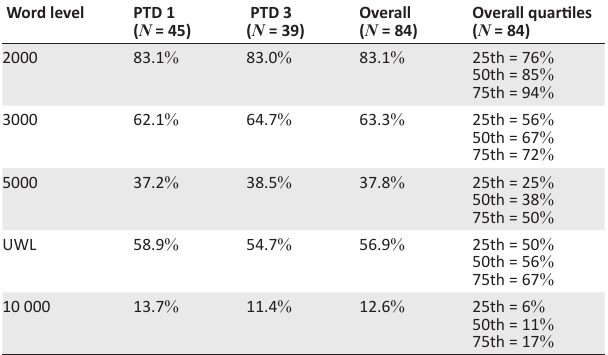
Source : Date compiled by author for article Values are given as means. PTD, Primary Teacher’s Diploma; SD means Standard Deviation. TABLE 5: Word Levels Performance and Quartiles. Word